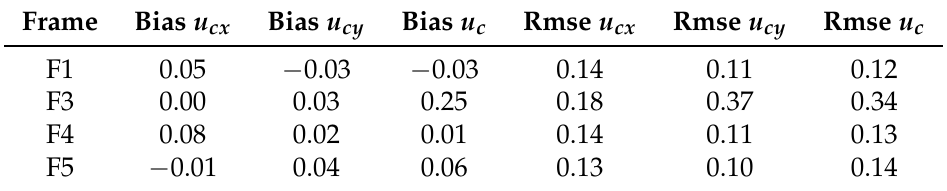
Table 1. Root-mean-square error [m/s] and bias [m/s] between measured and modelled